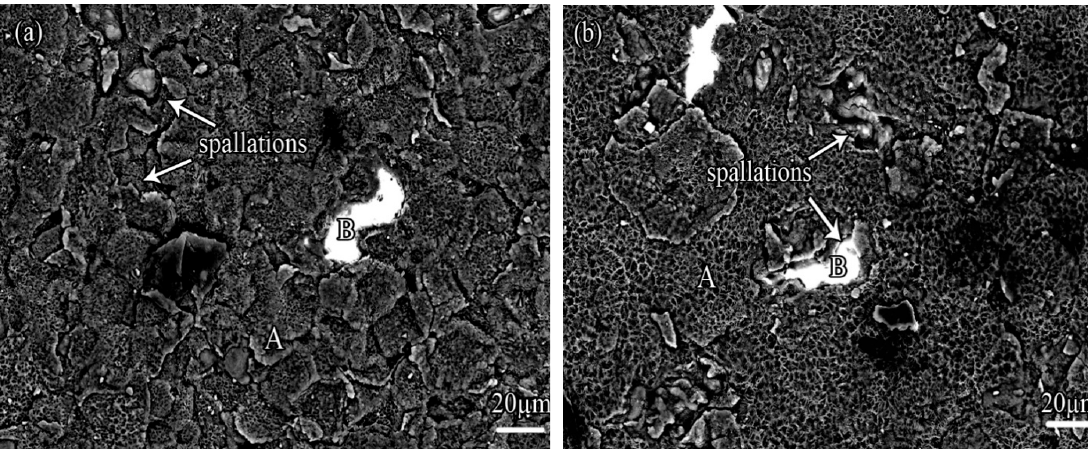
Figure 7. Surface morphologies of the coatings after oxidation at 1100 °C for 320 h: ( a ) PtAl and ( b ) PtSiAl.